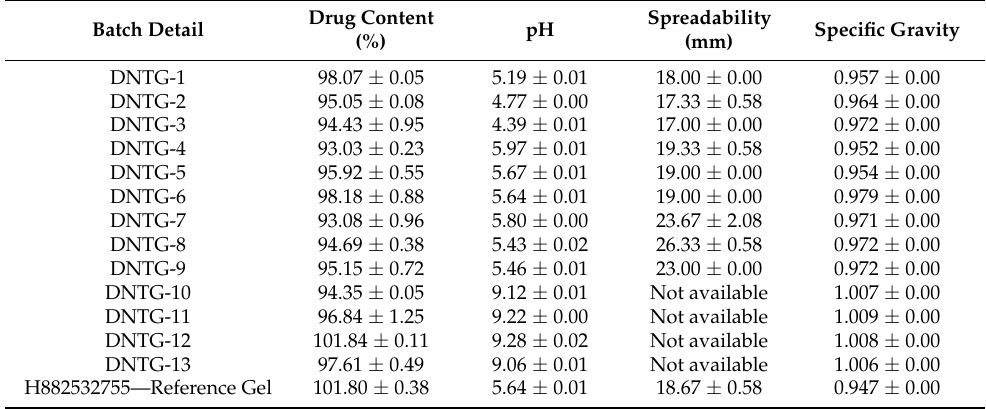
Table 4. Drug content, pH, spreadability, and specific gravity for desoximetasone niosomal gel and reference gel ( n = 3, mean ±